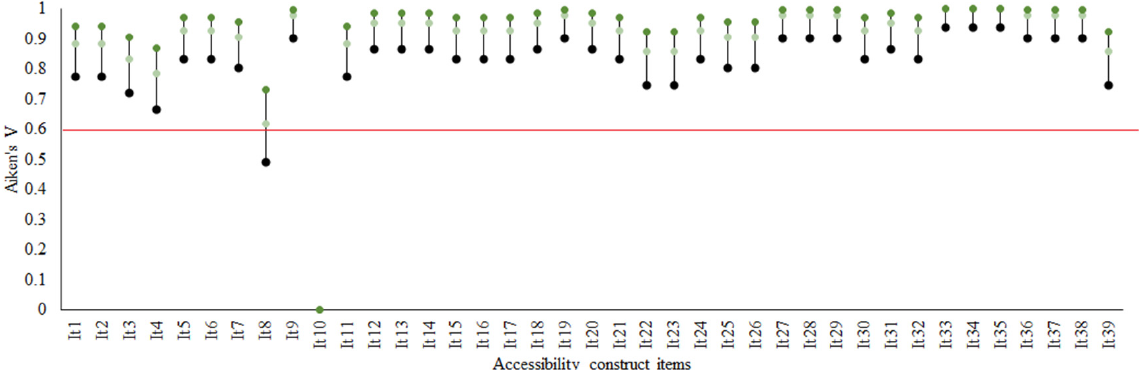
Figure 2. Aiken’s V and confidence intervals for relevance as evaluated by expert-judges ( n = 7) according to the Accessibility construct.